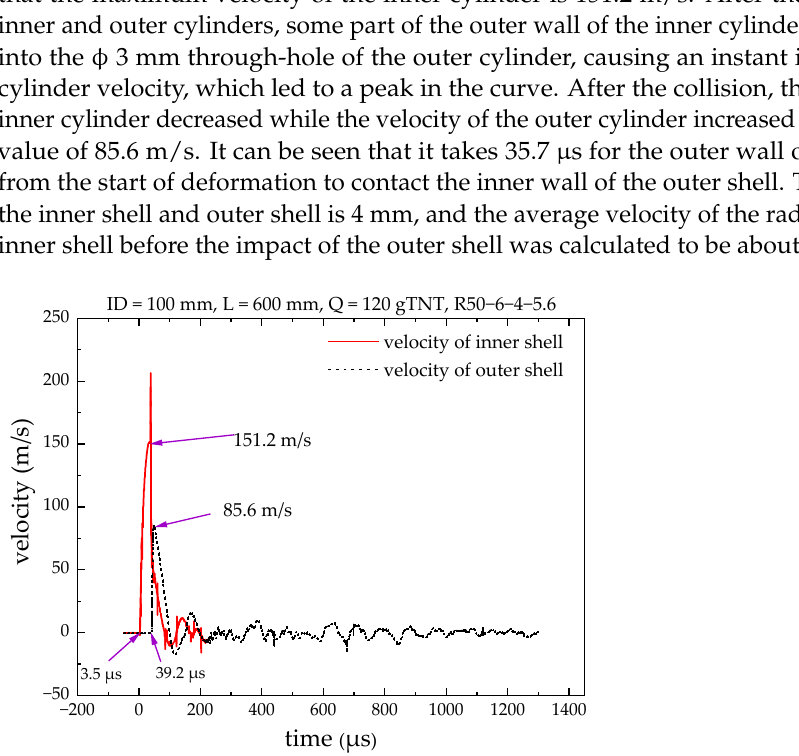
Figure 5. Velocity of double-layer shells measured by PDV.